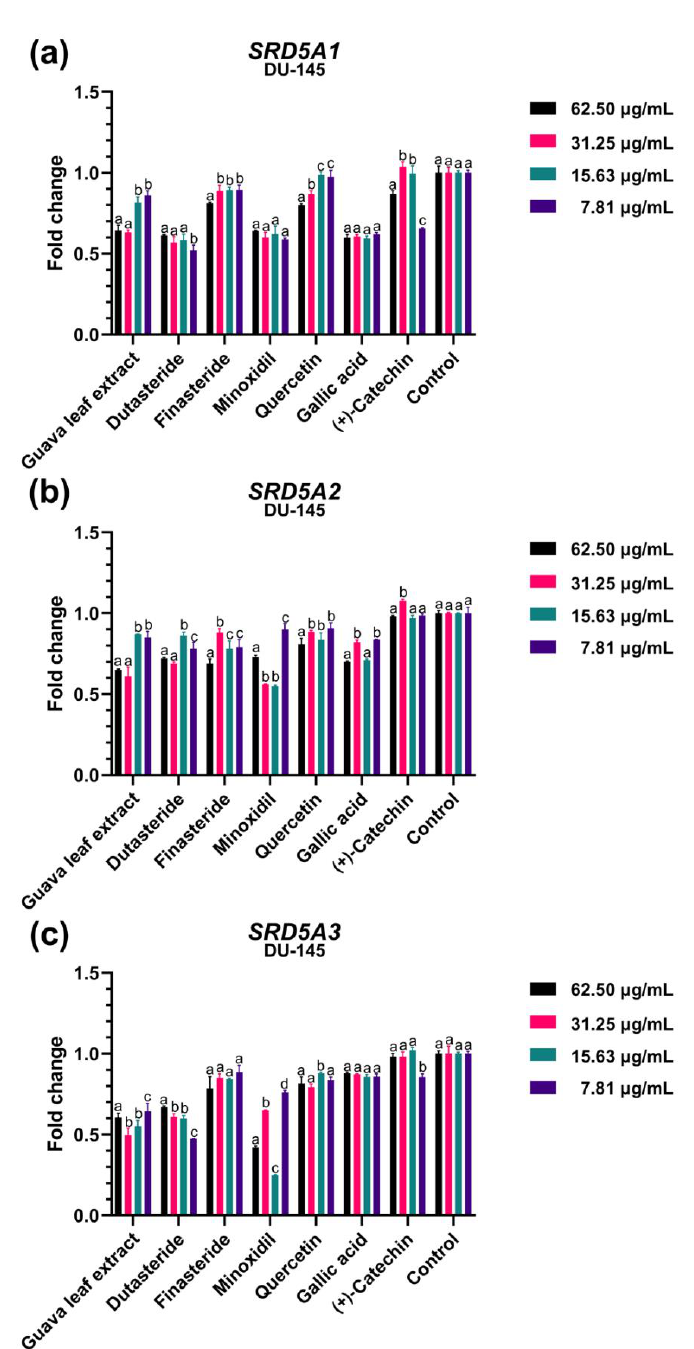
Figure 3. The effects of the guava leaf extract and standard reference compounds (dutasteride, finasteride, minoxidil, quercetin, gallic acid, and (+)-catechin) at different concentrations (62.50, 31.25, 15.63, and 7.81 μg/mL) on the expression of ( a ) SRD5A1, ( b ) SRD5A2 , and ( c ) SRD5A3 in human prostate cancer cells (DU-145). Values not sharing the same superscript letter are significantly different ( p < 0.05) when compared between concentrations of each treatment.